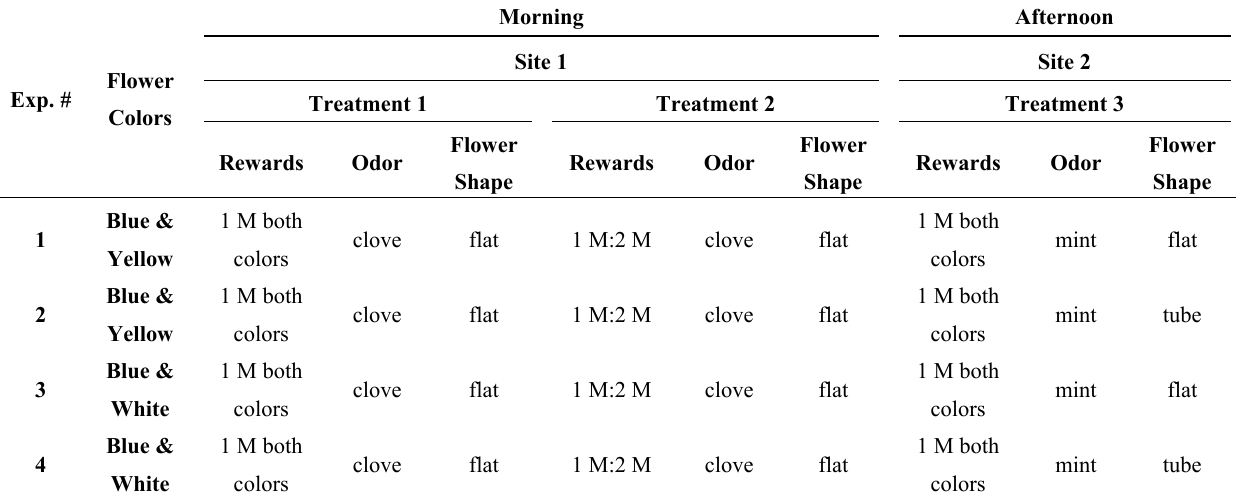
Table 1. Summary of treatments in each experiment. In Treatment 2, one of the two flower colors offered 2 M sucrose reward and the other 1 M sucrose reward. Half of the trials of each experiment were with blue flowers offering the 2 M reward, and the other half of the trials were with the alternative flower color offering the 2 M